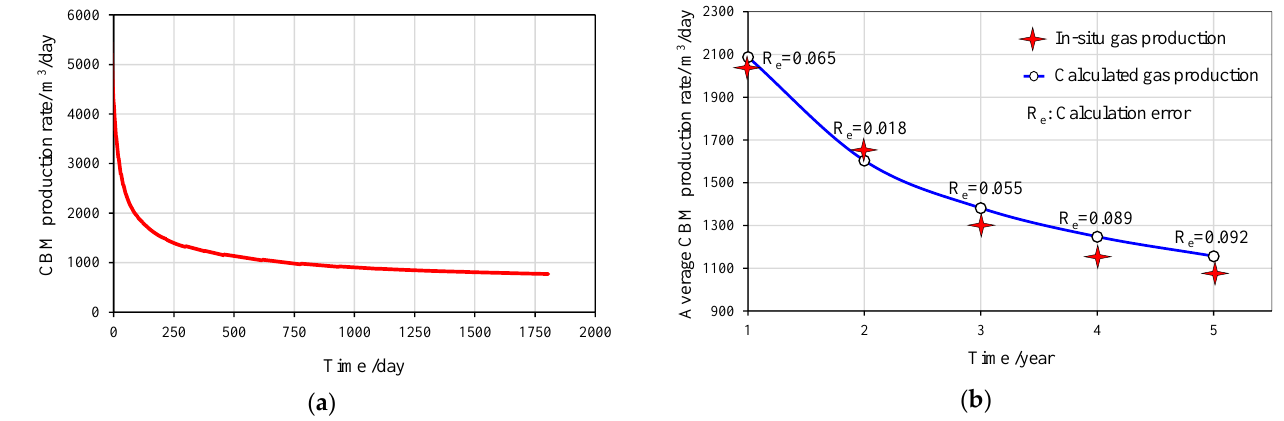
Figure 8. CBM production rate within 5 years. ( a ) CBM production rate at different production times and ( b ) the average CBM production rate after exploited different years.